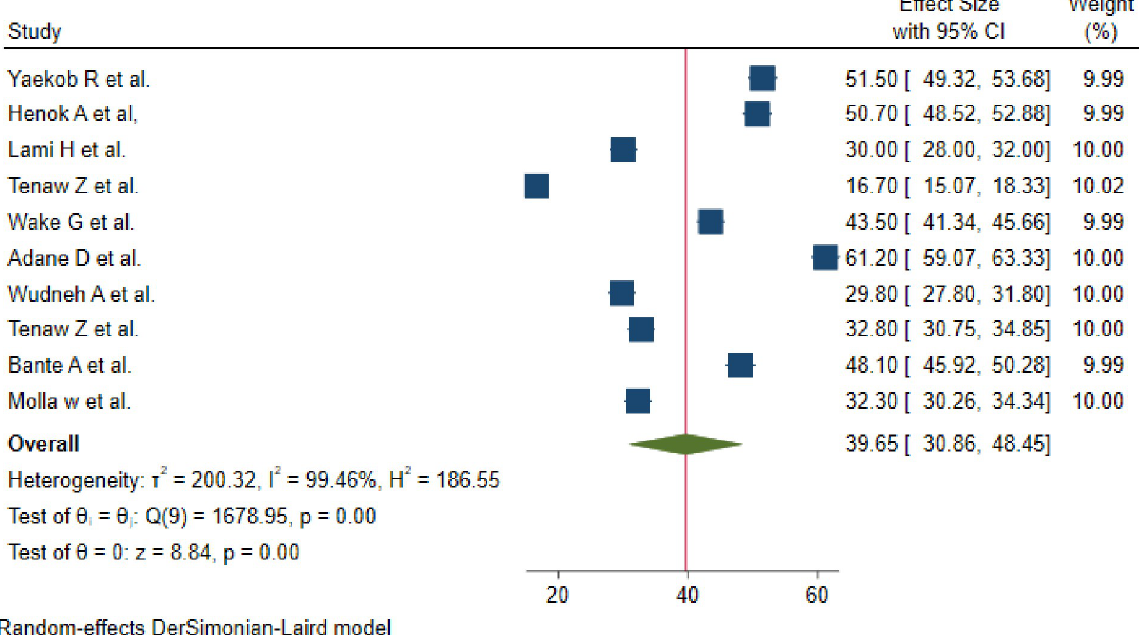
Fig 2. Forest plot of the pooled prevalence of practices of active management of the third stage of labor in Ethiopia.